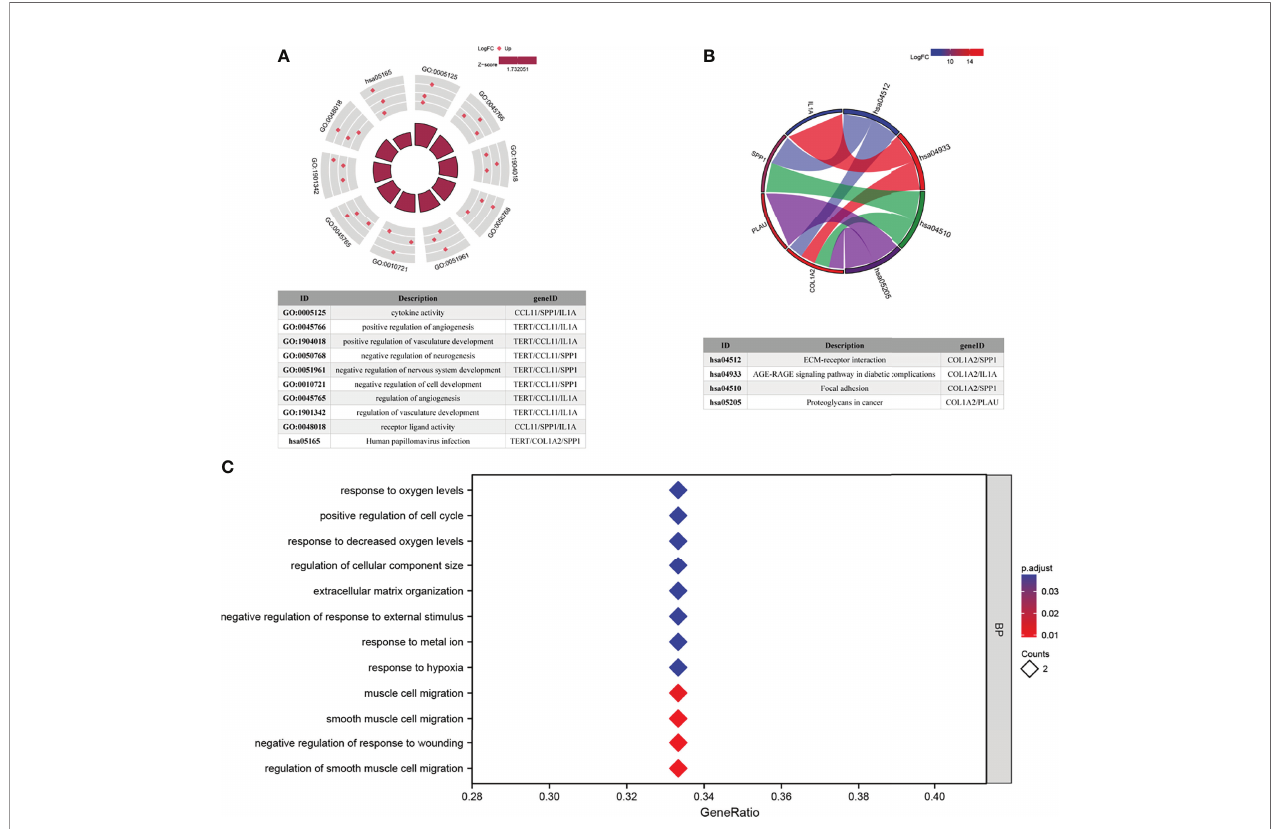
FIGURE 5 | Functional enrichment analyses of AFOC-DEGs. (A) GO and KEGG pathway enrichment data for AFOC-DEGs (the top 10 are shown). (B) KEGG pathway enrichment data for AFOC-DEGs (the top 4 are shown). (C) GO pathway enrichment data for AFOC-DEGs (the top 12 are shown). GO, Gene Ontology; KEGG, Kyoto Encyclopedia of Genes and